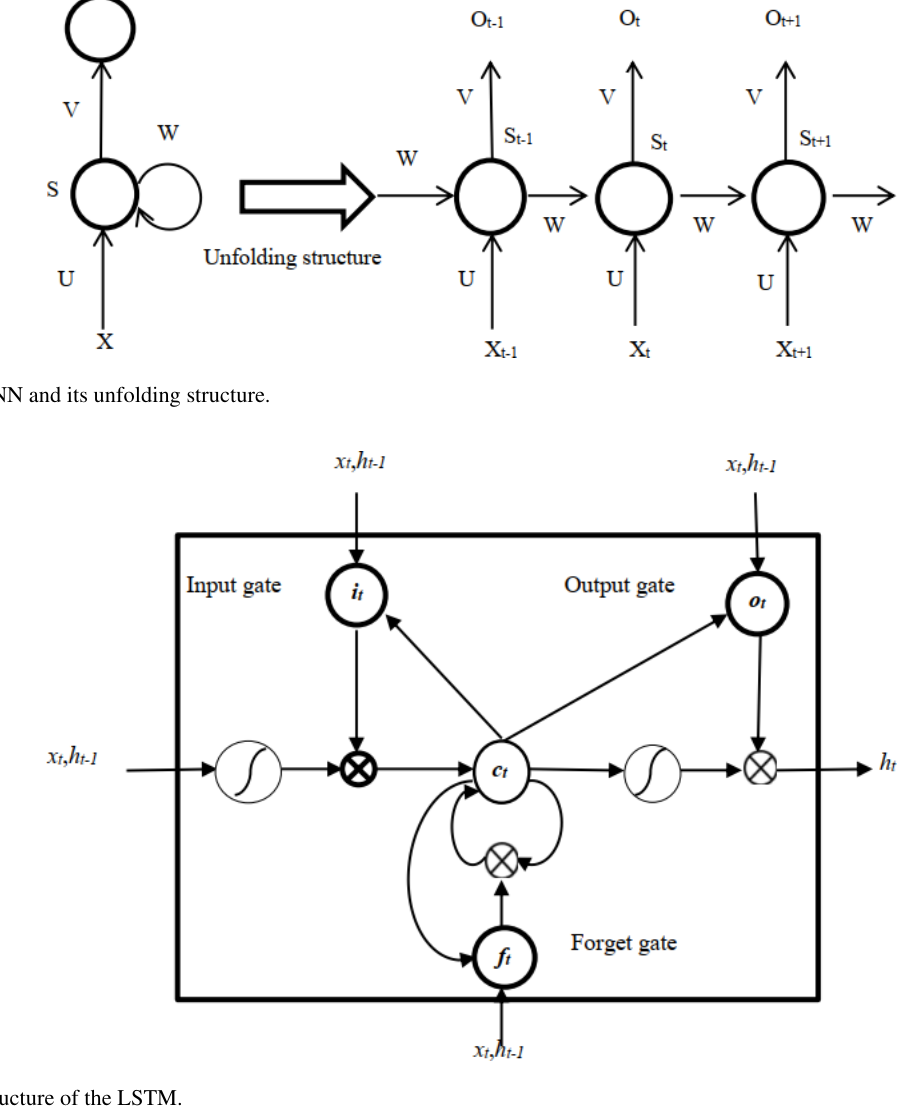
Figure 4. The structure of the